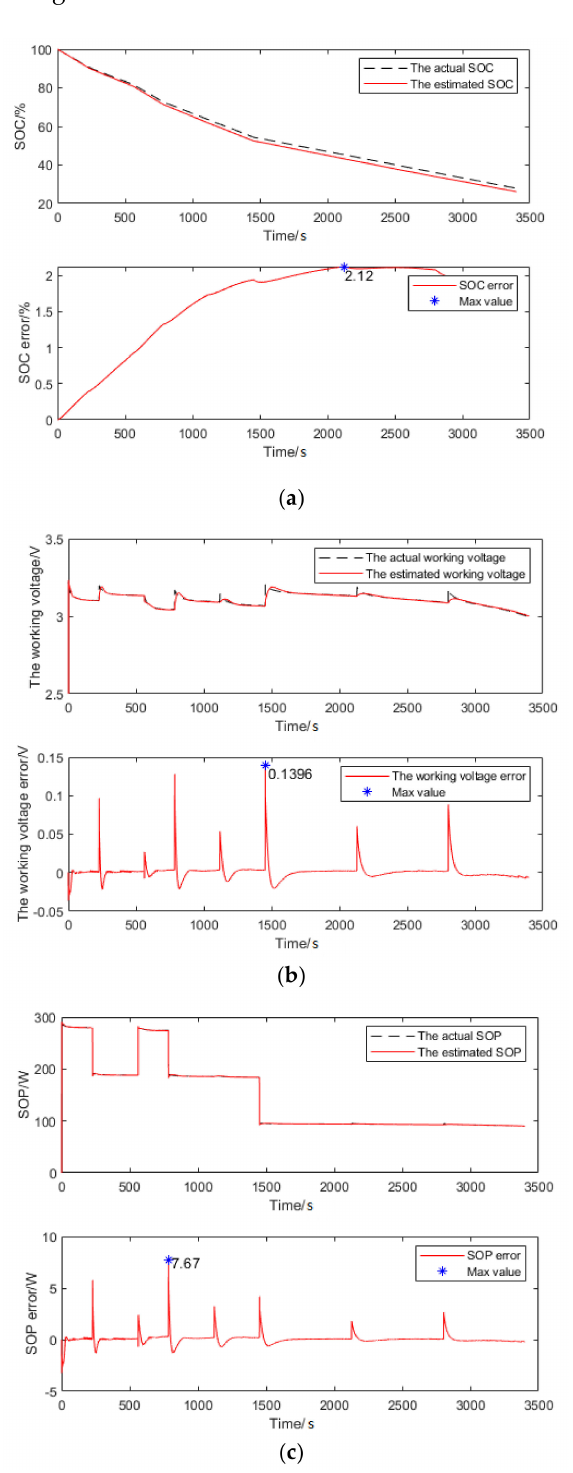
Figure 4. The simulation verification curve when the initial value of the SOC is 100%. ( a ) The SOC estimation and error curves. ( b ) The working voltage estimation and error curves. ( c ) The SOP estimation and error